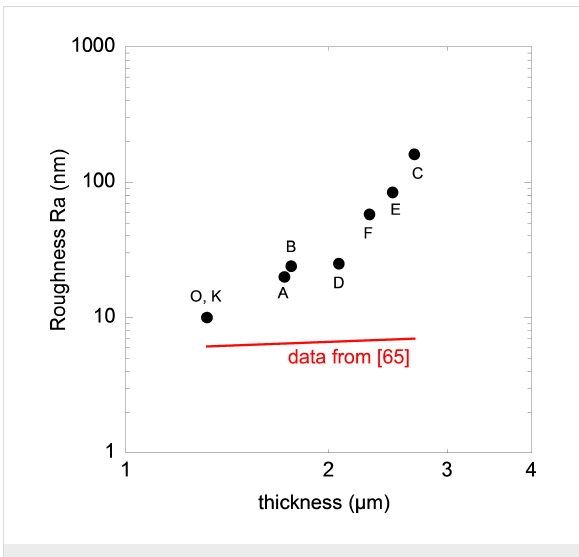
Figure 4: Roughness (Ra) as a function of the thickness. The red curve is the trend for pure parylene C films obtained in [65].